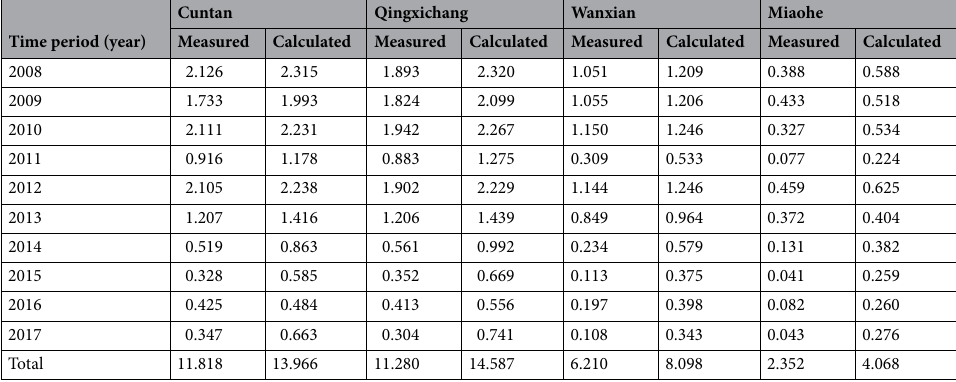
Table 4. Verification table of the sediment discharge at the main stations (unit: 100 million t).